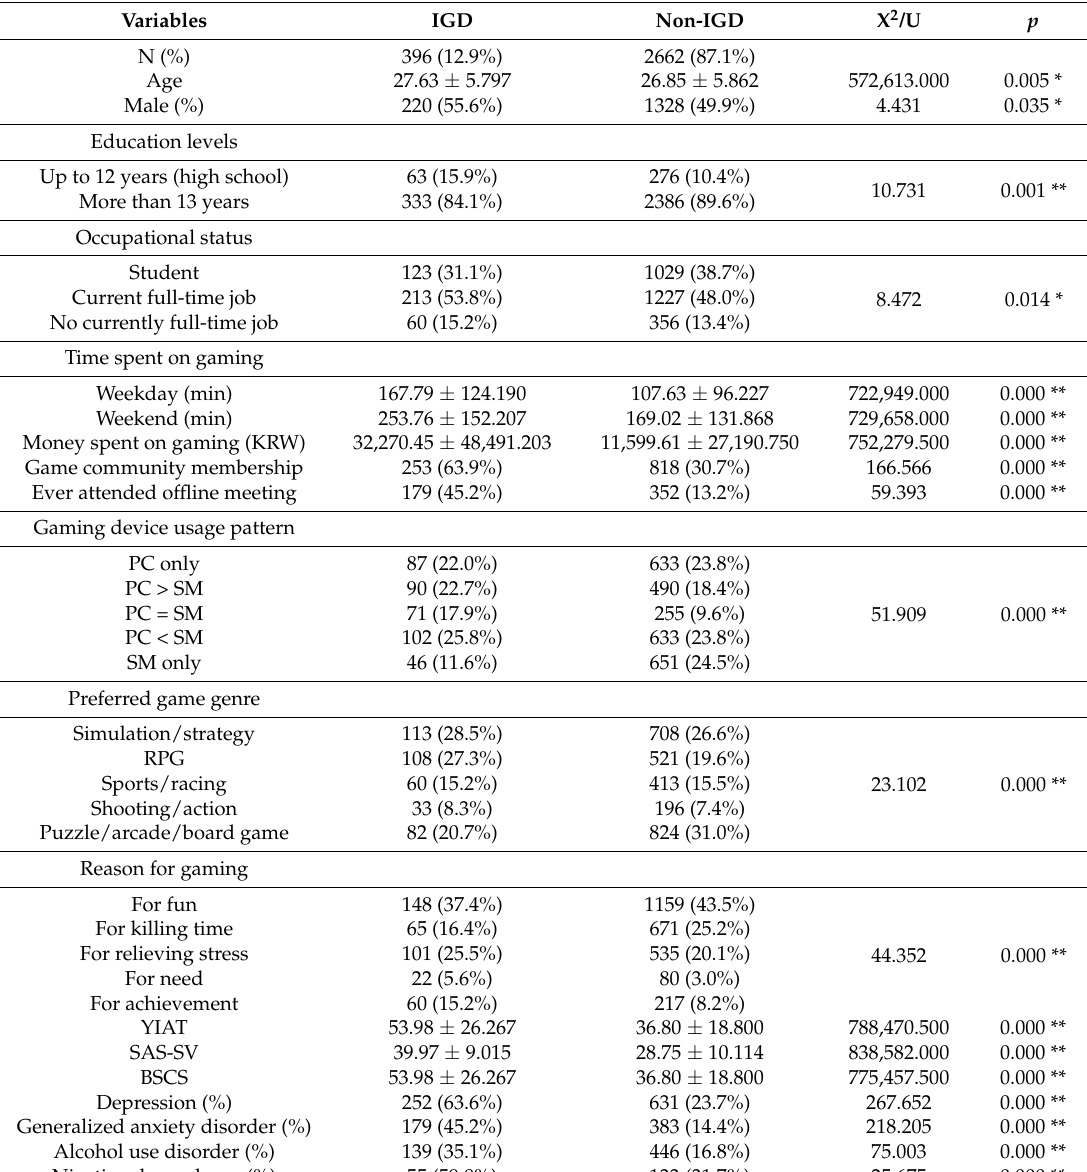
Table 1. Comparison between the IGD and non-IGD